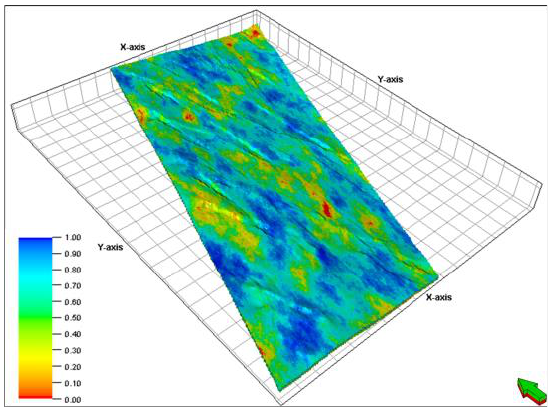
Figure 15. The trend derived from normalization of shale volume model. It is used as a constraint in